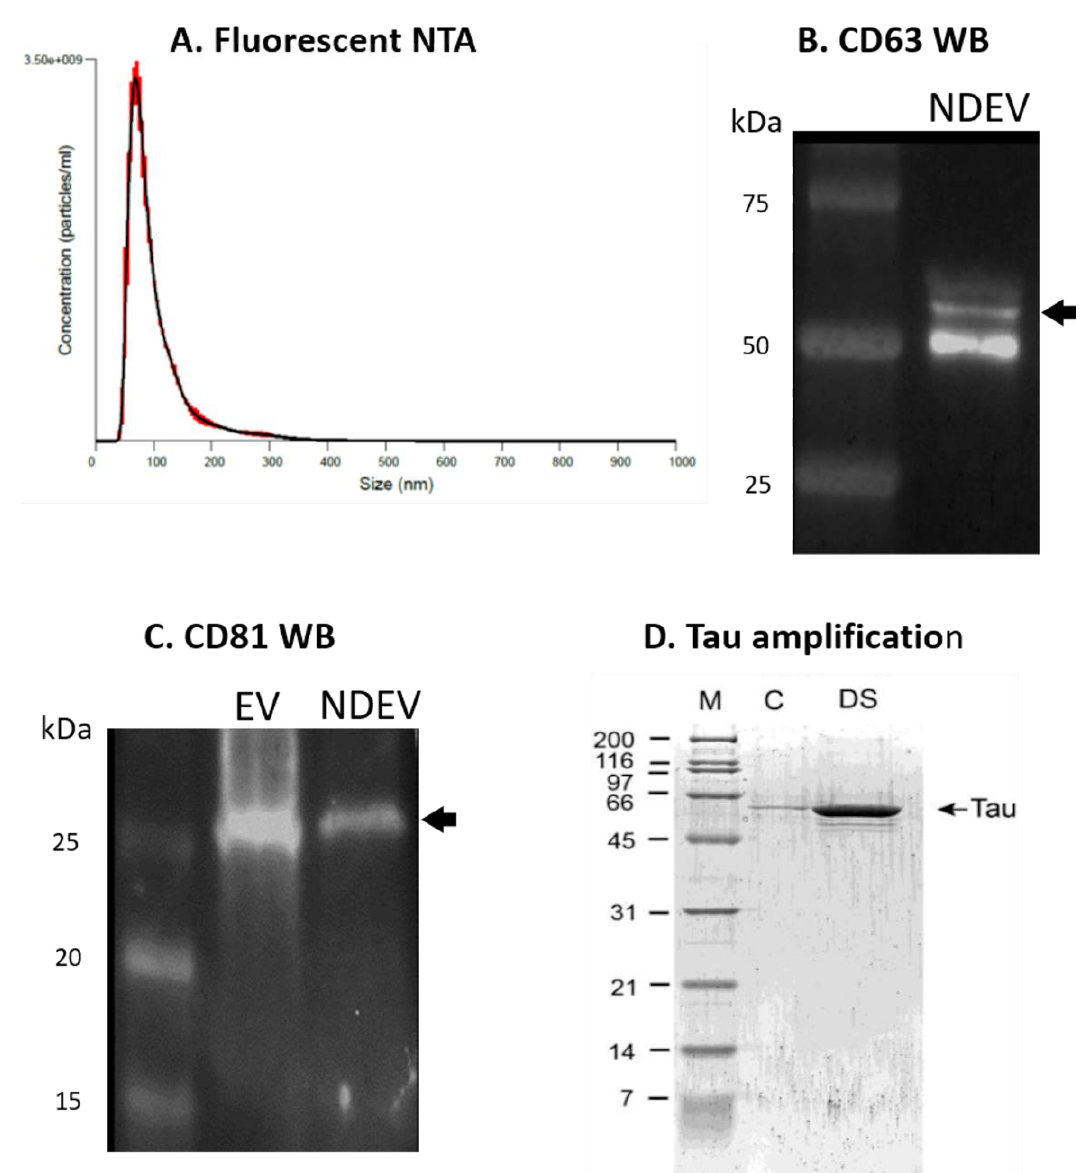
Figure 2. NDEV characterization. ( A ) Fluorescent nanoparticle tracking analysis illustrating size distribution and concentration of extracellular vesicles in neuron-derived exosome samples. The single peak at ≈100 nm suggests small extracellular vesicle (EV)-specific enrichment. ( B ) Representative Western blot image of CD63 tetraspanin protein indicative of EV enrichment. CD63 (System Biosciences, EXOAB-CD63A-1) was detected at 53 kD in NDEVs isolated from human plasma via Western blot. ( C ) Representative Western blot showing tetraspanin CD81 (SAB3500454, Sigma Aldrich) at 25 kD in total EVs ( EV ) from human plasma (System Biosciences, EXOP-500A-1) and neuron-derived EVs ( NDEV ) isolated from human plasma. ( D ) Amplification of Tau fibrils from NDEVs obtained from blood. M = marker, C = control NDEVs, DS = NDEVs from plasma from a subject with Down syndrome.